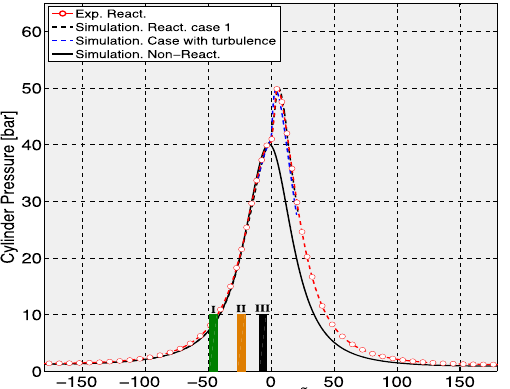
Figure 2. Experimental pressure trace and large eddy simulation (LES) pressure trace, with the first, second, and third injection events, which are indicated as II, II, and III, for the baseline case 1.